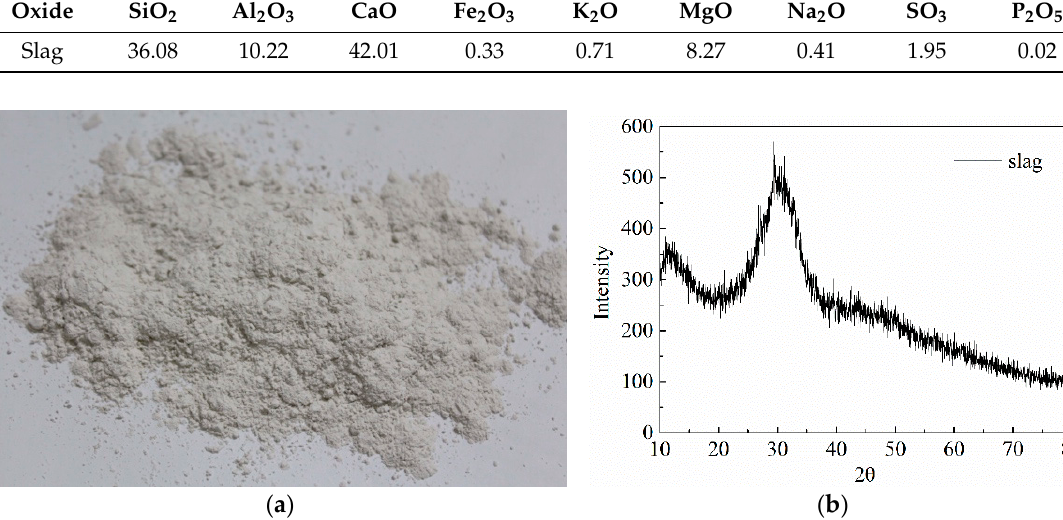
Figure 1. Blast furnace slag: ( a ) photograph; ( b ) XRD diffractogram.